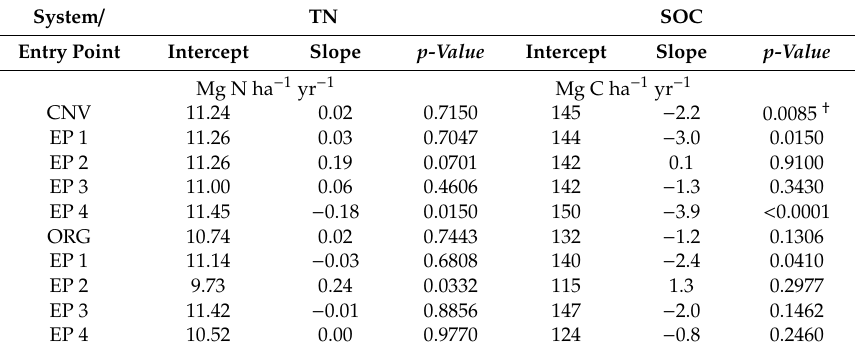
Table 7. Intercept, slope, and p -value for slope of linear regressions of change in soil total N (TN) and organic C (SOC) in the 0–60 cm depth from 2002 to